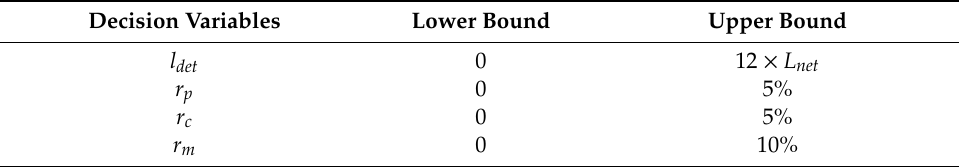
Table 7. Definition of decision variable